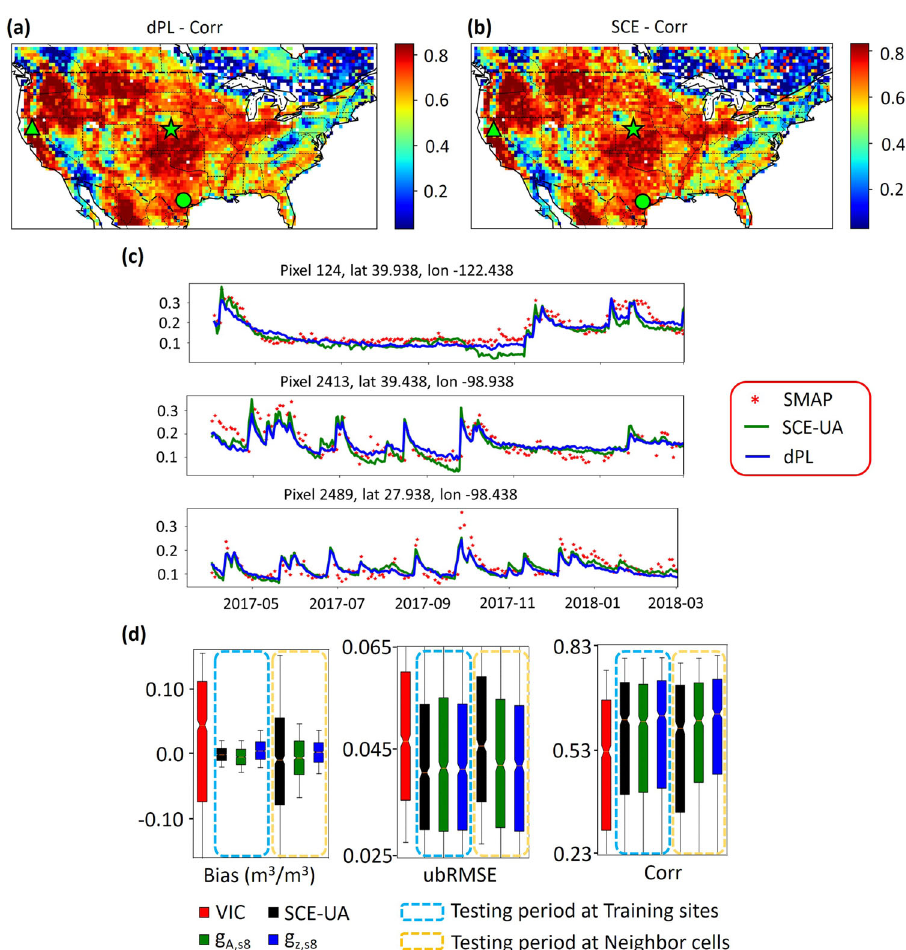
Fig. 3 Performance of SMAP soil moisture simulations. a Map of correlations between observed (Soil Moisture Active Passive satellite, SMAP) and simulated (dPL g Z ) soil moisture during test period at 1/4 2 sampling density. Green symbols (triangle, star, and circle) indicate three randomly selected sites. b Same as a except using simulated soil moisture from evolutionary algorithm SCE-UA. c Example time series at three randomly selected sites. d Boxplots summarizing gridcell metrics for temporal generalization (evaluated on the training locations over the test period, blue dashed box) and spatial generalization (orange dashed box) tests at 1/8 2 sampling density (one gridcell from an 8x8 patch, see illustration in Supplementary Fig. S1) for VIC (NLDAS-2 default parameters), SCE-UA, and dPL options g Z and g A . In the spatial generalization test, we sampled at 1/8 2 density for training and evaluated the parameters ’ performance on a neighbor 3 rows to the north and 3 columns to the east from each of the training gridcells, over the test period. Results from another year are similar (Supplementary Fig. S5). We tested on other neighboring gridcells as well, with similar results (data not shown). The boxplots ’ lower whisker, lower box edge, middle line, upper box edge, and upper whisker represent 10 th , 25 th , 50 th , 75 th , and 90 th percentiles,